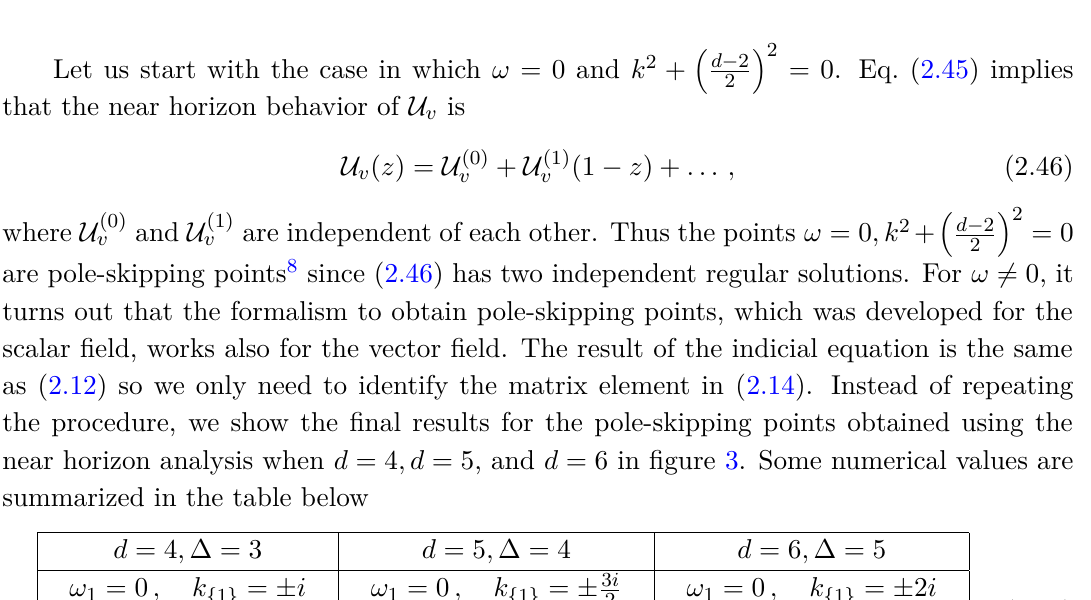
Figure 3 . Locations of the pole-skipping points of longitudinal